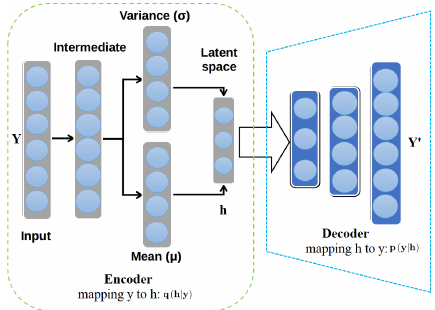
Figure 2. Variational autoencoder